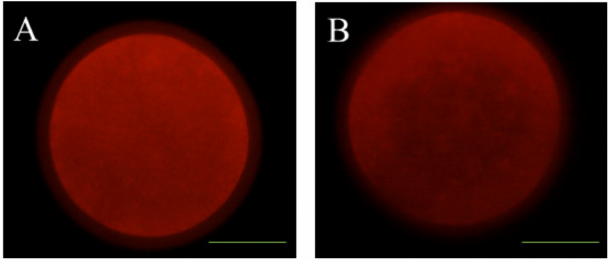
Figure 5. Representative images of mitochondrial distribution of sheep oocytes. ( A ) Red mitochondria normally distributed (homogeneous distribution; Figure 5A); ( B ) red mitochondria abnormally distributed (Figure 5B). Scale bar = 24 µ